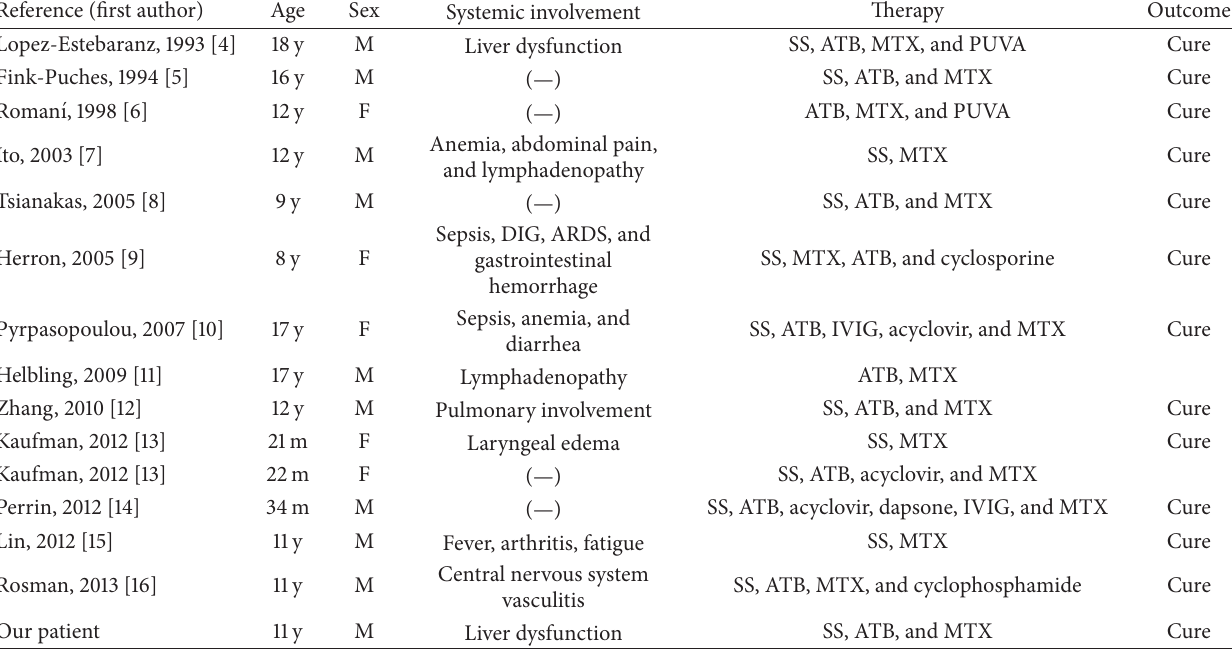
Table 1: Literature